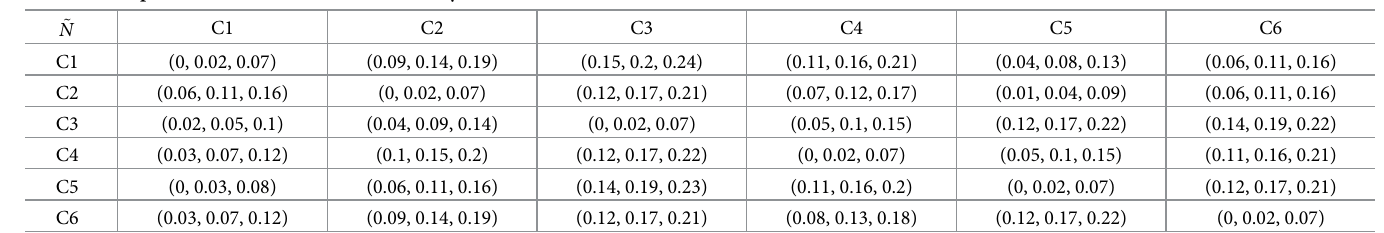
Table 6. Computation of the normal matrix of fuzzy direct contact.